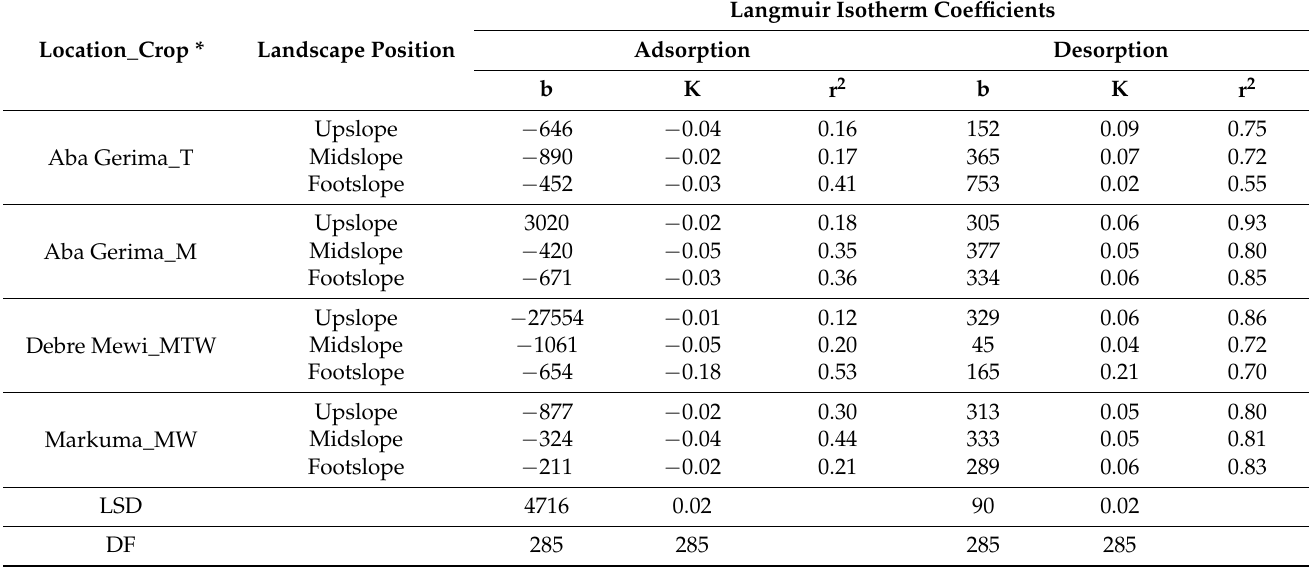
Table 4. Langmuir coefficients for adsorption and desorption isotherms.